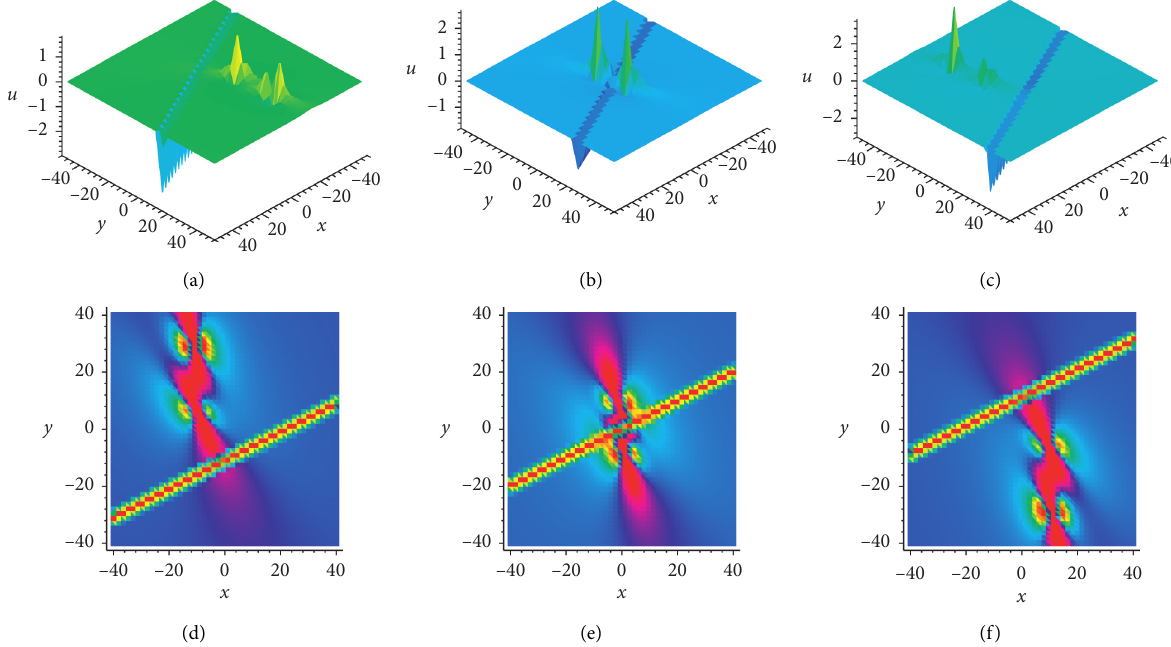
Figure 8: Evolution graphs of the third-order lump solution: (a), (b), and (c) three-dimensional plots at t � − 5, t � 0, and t � 5 and (d), (e), and (f) density plots at t � − 5, t � 0, and t �